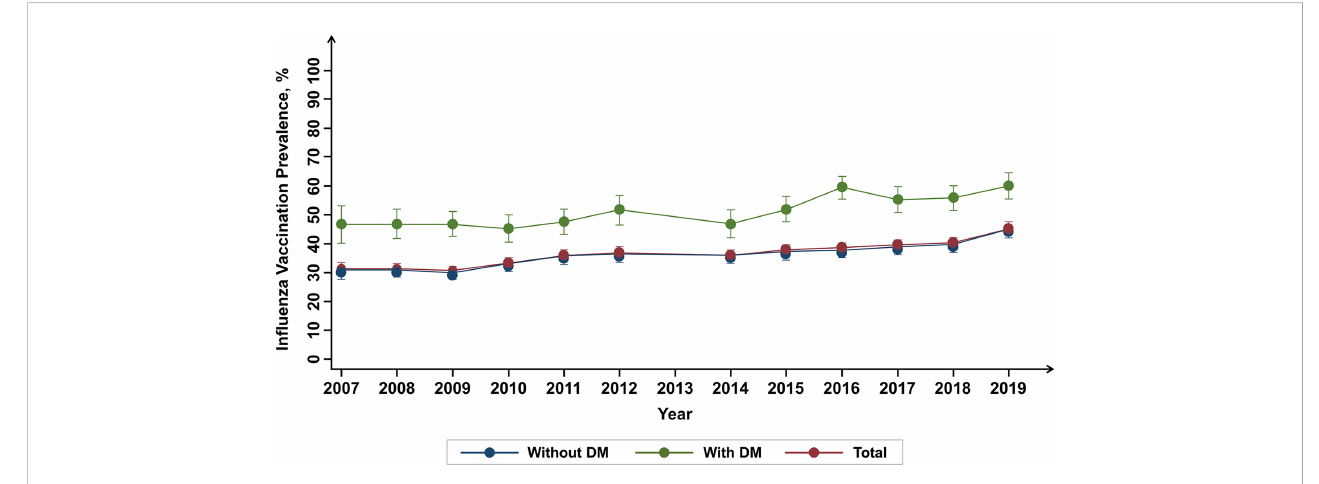
FIGURE 2 In fl uenza vaccination trends over 13 years according to the diabetes mellitus